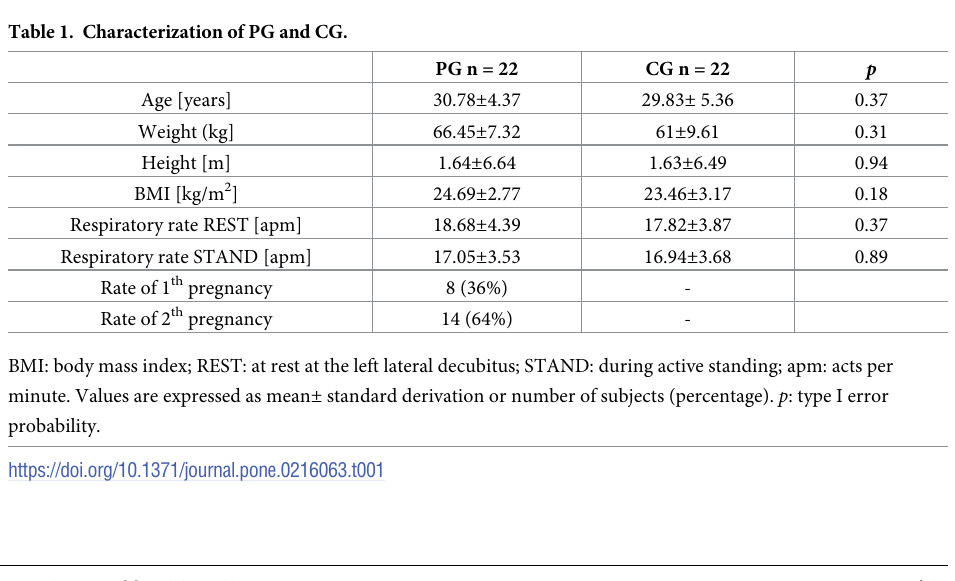
Table 1. Characterization of PG and CG.